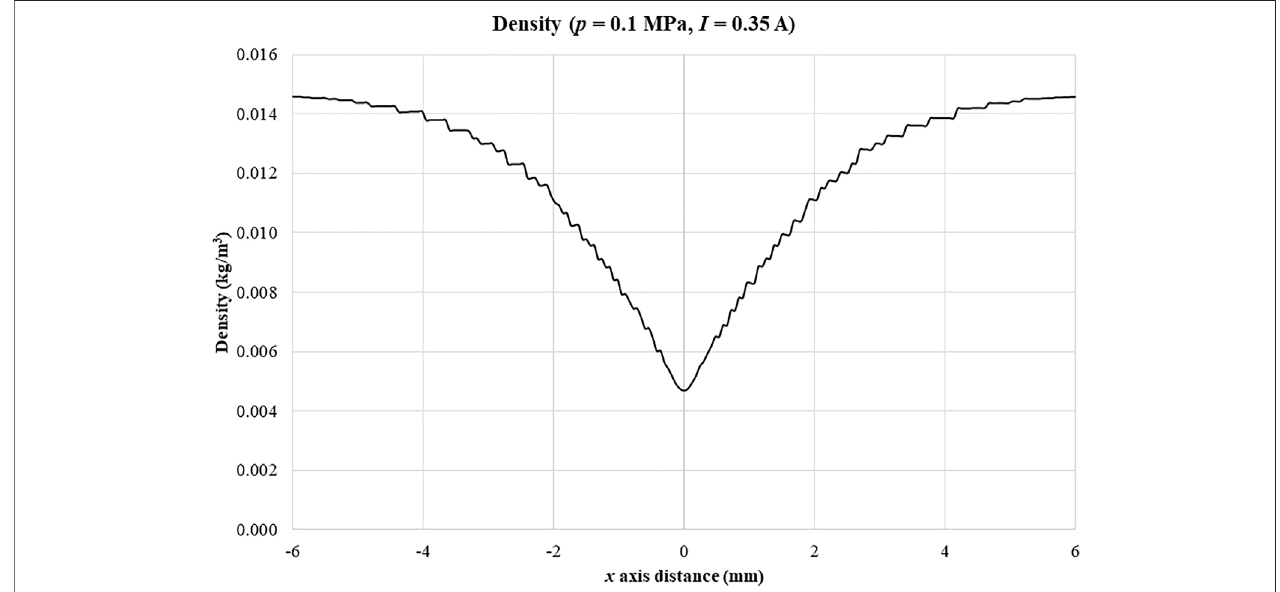
FIGURE 11 | Density in the x axis direction at the center of the inter-electrode gap ( t (cid:2) 50 ms, p (cid:2) 0.1 MPa, I (cid:2) 0.35 A).